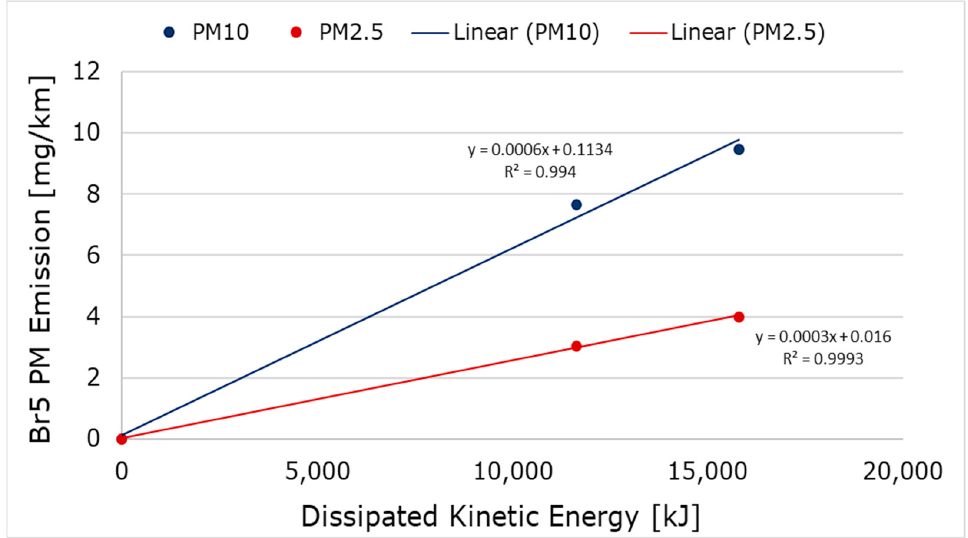
Figure 8. PM2.5 and PM10 emissions as a function of the dissipated kinetic energy. The solid blue and red lines identify the ideal regression lines for PM10 and PM2.5, respectively. and red lines identify the ideal regression lines for PM10 and PM2.5,